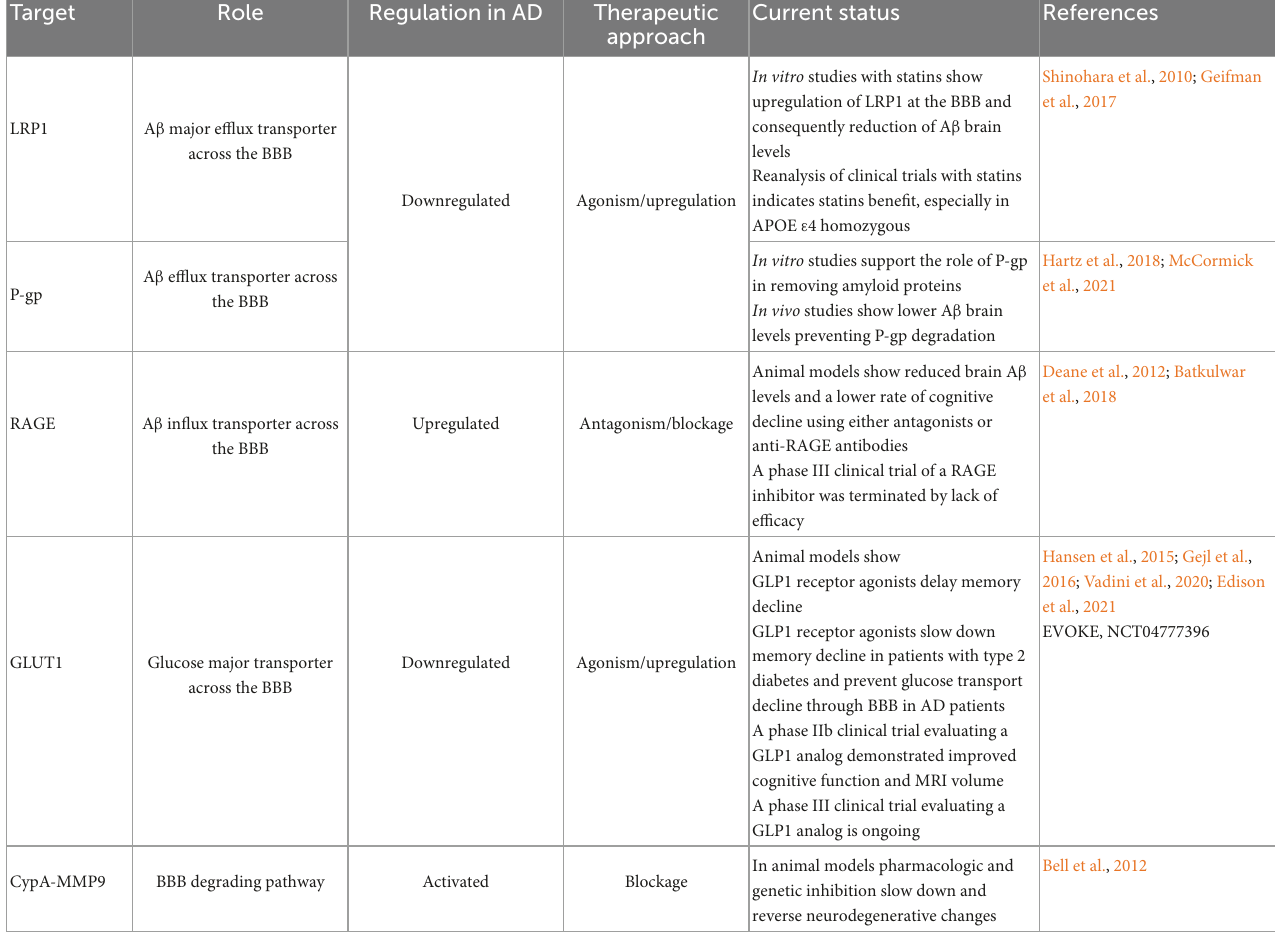
TABLE 1 Blood-brain barrier targets in Alzheimer’s